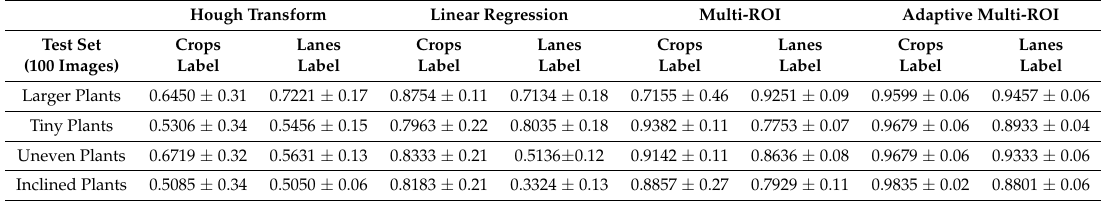
Table 2. Crop Row Detection Accuracy for the estimated centerline over the testing image